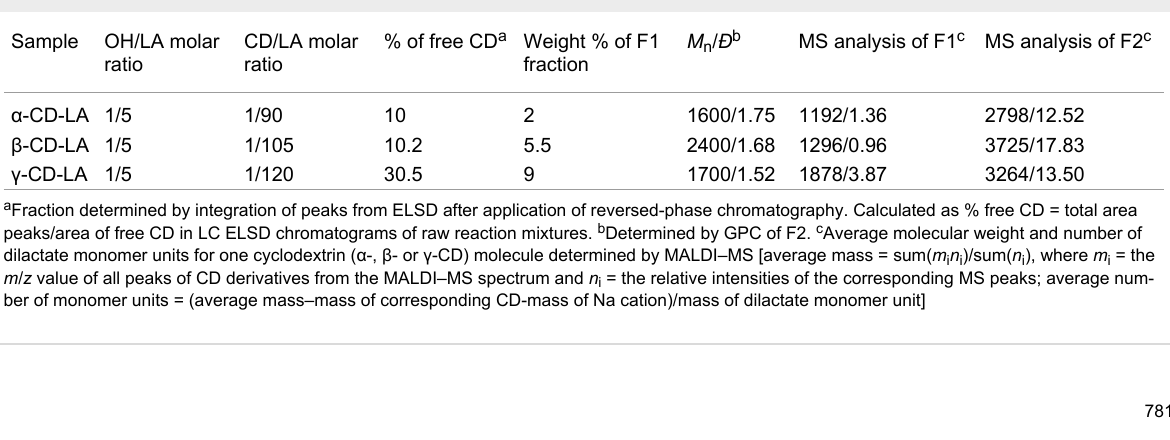
Table 1: Characterization of CD-LA products.